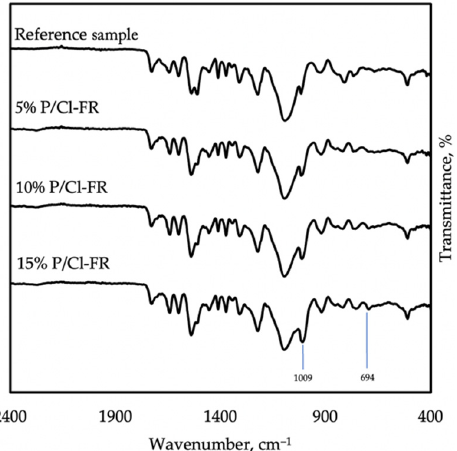
Figure 5. FTIR spectra taken on reference samples, 5% P/Cl-FR, 10% P/Cl-FR, and 15% P/Cl-FR, showing the influence of TCPP.